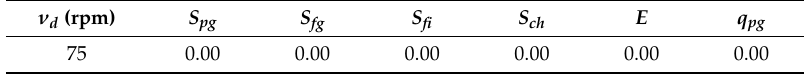
Table 6. Significance level for the ANOVA analysis.